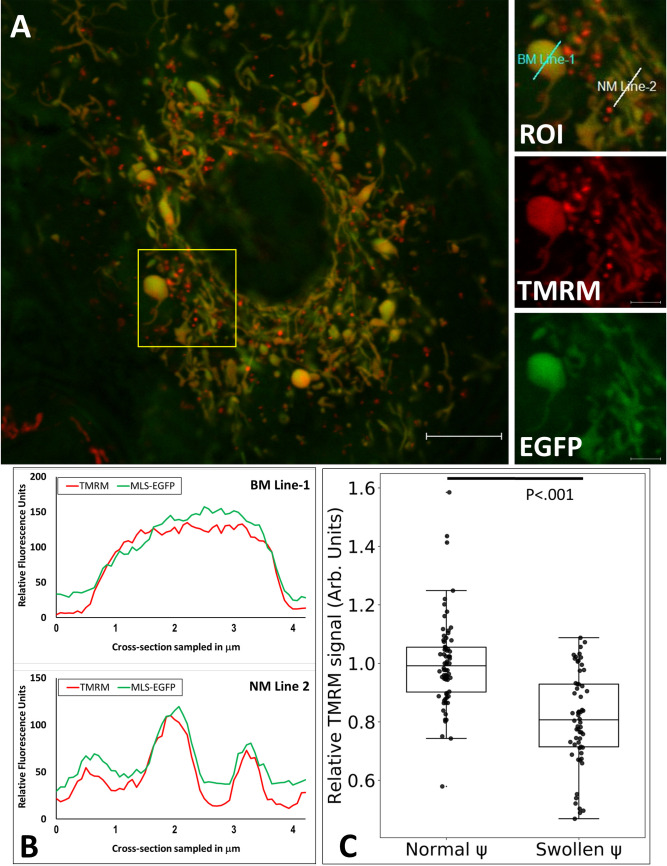
Assessment of the relative membrane potentials of bloated and normal morphology mitochondria via live confocal microscopy.A. RPMI-adapted A549 cells expressing MLS-EGFP were loaded with TMRM as described in Materials and Methods. Cells featuring mito-bulbs were imaged and analyzed by tracing the red and green channel signals through regions featuring either mito-bulb or normal tubular morphology mitochondria. Panels on the right show the enlarged ROI boxed in A to indicate the locations of sampling lines and the resolved colors. Scale bar is 10 μm. Leica SP8, 63x, 5% CO2, 37⁰C, 95% relative humidity, operating in photon-counting mode. B. Sample trace data from the TMRM and EGFP channels. The upper panel depicts a trace through a mito-bulb, “BM Line-1” in A. The lower panel depicts a trace bisecting through three mitochondria with normal morphology, “NM Line-2” in A. Traces follow lines from the lower left to upper right. C. The relative TMRM staining intensity normalized to matrix GFP is shown for normal tubular and swollen, mito-bulb mitochondria. Confocal microscopy images from 24 cells, over 3 separate experiments, totaling 132 independent 5 μm mitochondrial traces were processed from data similar to that displayed in A and B. The boxplot shows median and quantile values. Welch’s t-test, t = 6.96, p < .0001.